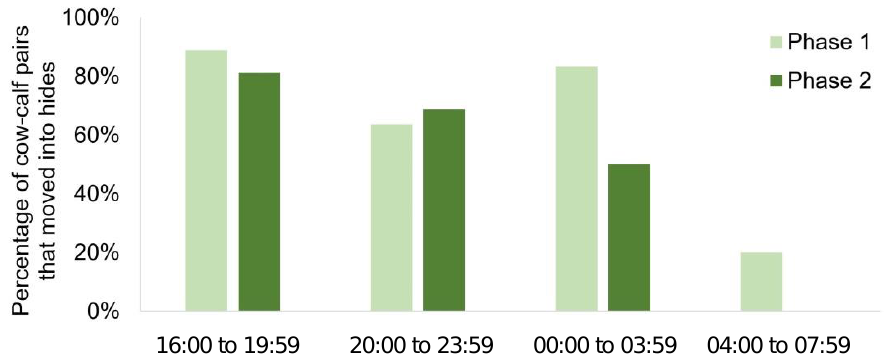
Figure 5. The percentage of cow–calf pairs that moved into hides after calving in the late afternoon, evening, middle of the night or early morning for both phases of the study. Phase 1 ( n = 49) had consistently managed stocking density, daily bedding cleaning, and random allocation of cows to 1 of 2 calving pads each night. Phase 2 ( n = 41) followed the farm’s standard practice, with variable stocking density on both calving pads, and no bedding maintenance. Note: Results for 04:00 to 07:59 could have been impeded by the presence of farm personnel at approximately 05:30.